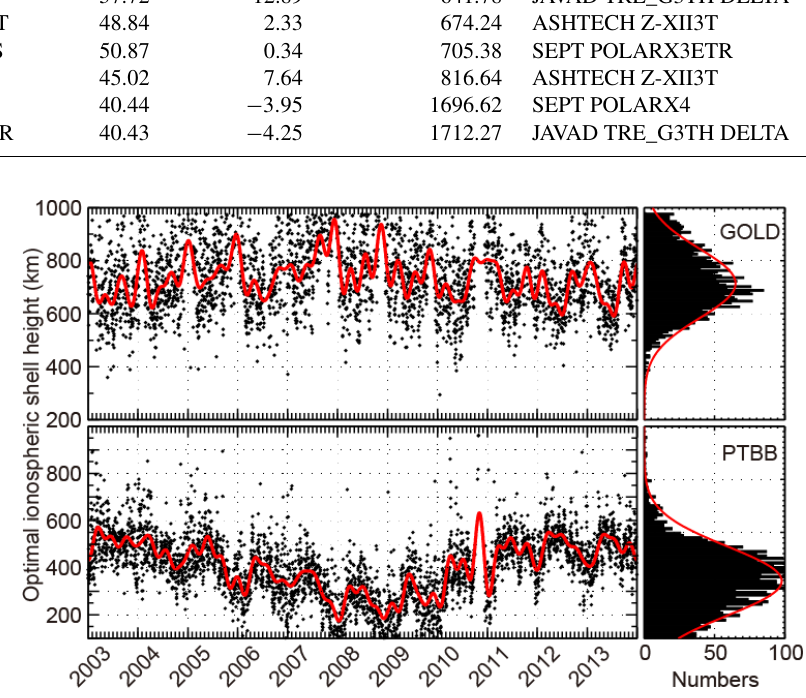
Figure 2. Variation in the daily optimal ionospheric shell height (black) and the fitting result (red).